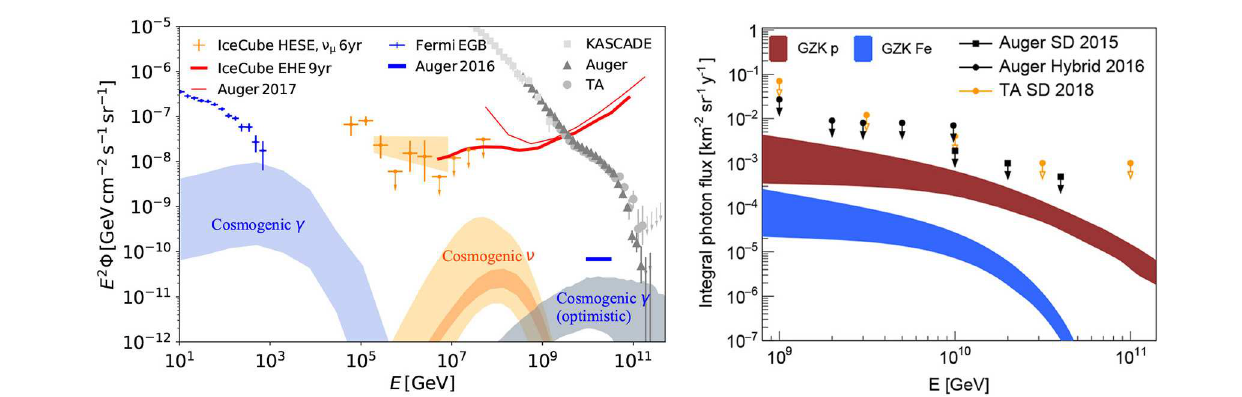
FIGURE 6 | Left: Cosmogenic photon (blue) and neutrino (orange) fluxes for models that fit the Auger data including spectrum and composition (Alves Batista et al., 2019). Specifically, the dark orange band corresponds to a best-fit model with 99% CL, and the light orange band covers the AGN, star-formation rate (SFR), and gamma-ray burst (GRB) models for fits at 90% CL (Alves Batista et al., 2019). In more optimistic models that assume a larger maximum energy R max second photon bump appears at 1–10 EeV as indicated by the gray shaded area (Decerprit and Allard, 2011). In comparison, we show the fluxes of the six-year high-energy starting events (HESE, orange data points) (Kopper, 2018), six-year muon neutrino events (orange shaded region) (Aartsen et al., 2016d), nine-year extreme-high-energy (EHE) 90% upper limit ( Aartsen et al., 2018) measured by IceCube (thick red curve), and the 90% upper limit provided by Auger with data from 1 Jan 04 to 31 Mar 17 (thin red curve, Bellido, 2018), as well as the extragalactic gamma-ray background observed by Fermi -LAT (Ackermann et al., 2015, 2016), and the differential limit of UHE photons in the bin of 10–30 EeV by Auger ( Aab et al., 2017c). For reference, we also show the cosmic-ray spectra measured by KASCADE, Auger, and TA ( Abraham et al., 2008; Apel et al., 2013; Abbasi et al., 2018e). K. Fang for this review . Right: Upper limits on the integral photon flux obtained with the Auger surface detector (Auger SD 2015) (Aab et al., 2015c), a hybrid analysis of 9 years of Auger data (Auger Hybrid 2016) Aab et al. (2017c), and the Telescope Array surface detector (TA SD 2018) ( Abbasi et al., 2018c). The shaded regions give the predicted cosmogenic photon flux assuming a pure proton (GZK p) and pure iron (GZK Fe) UHECR composition of reference (Sarkar et al., 2011). F. Oikonomou for this